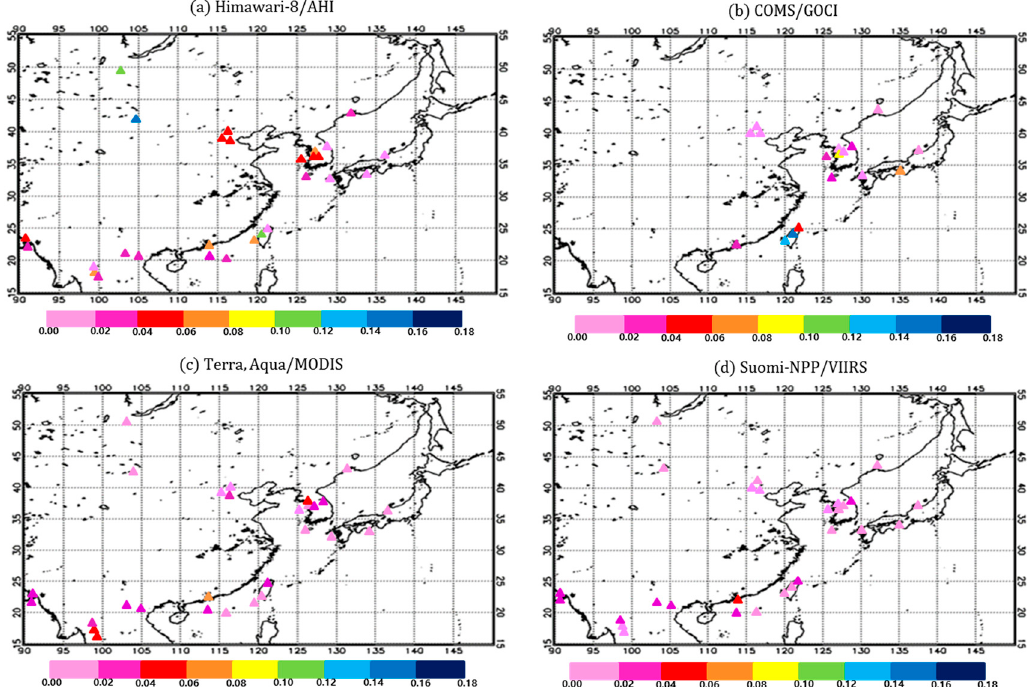
Figure 5. Statistical error (RMSE) analysis before and after applying a CDF comparing AERONET and satellite AOD values: ( a ) Himawari-8/AHI, ( b ) COMS/GOCI, ( c ) Aqua Terra/MODIS, and ( d )